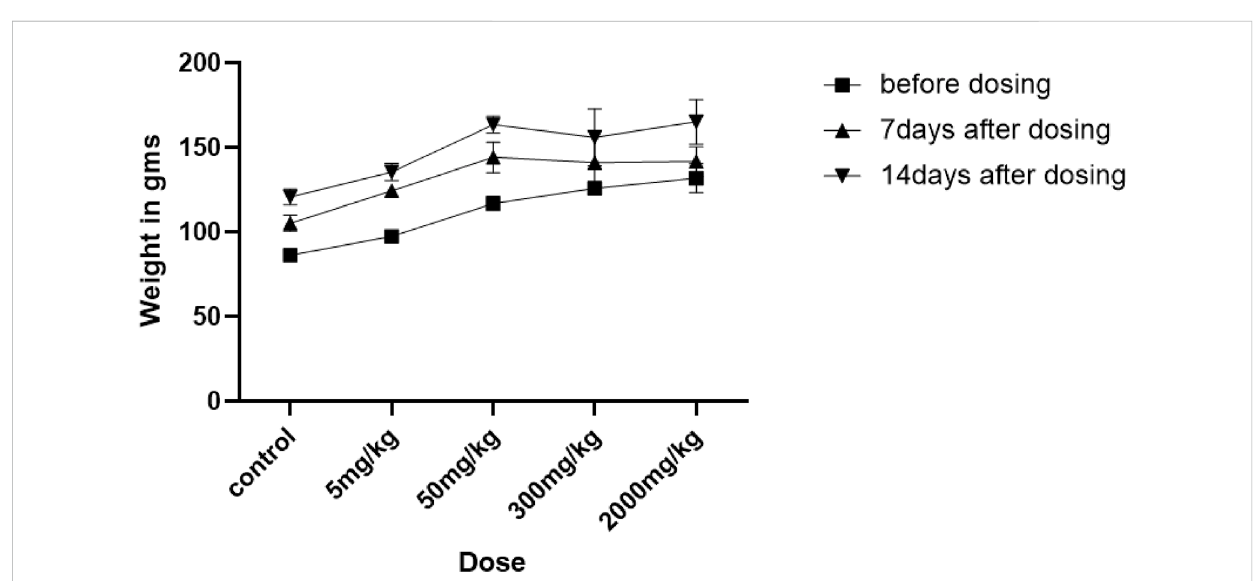
FIGURE 4 Changes in the weights of rats treated with different oral doses (5, 50, 300, and 2000 mg/kg and control) of Ipomoea turpethum extract loaded on polymeric nanoparticles at different time intervals (before dosing and 7 days after drug